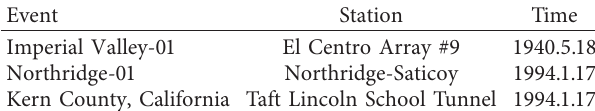
Table 6: Details of the 3 ground motions employed in this study.